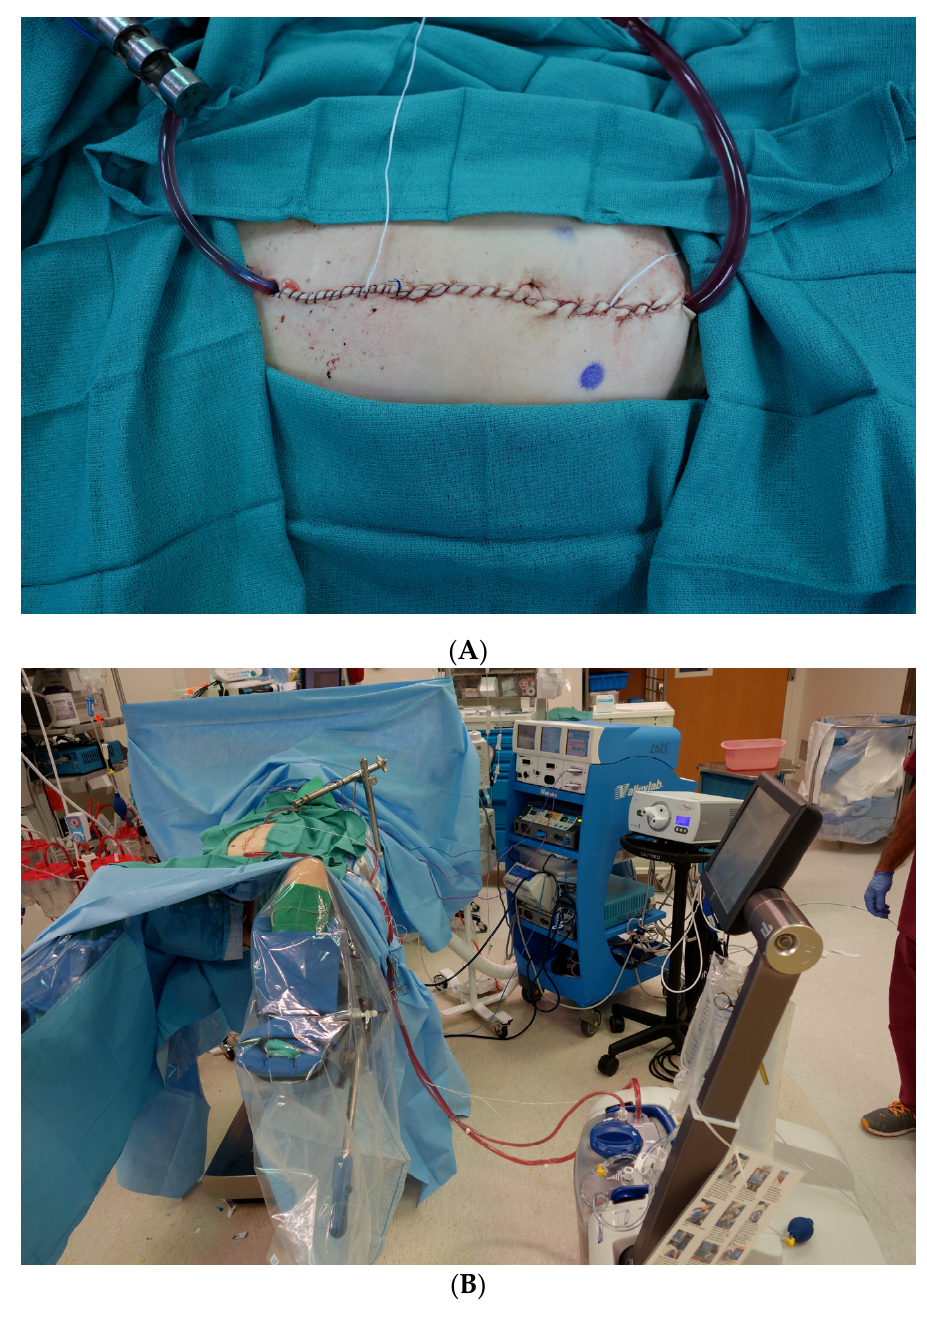
Figure 1. Hyperthermic Intraperitoneal Chemotherapy Perfusion During Cytoreductive Surgery. ( A ): Closed HIPEC Technique. The midline incision is temporarily closed to create a closed system for the infusion of chemotherapy into the peritoneal cavity. ( B ): HIPEC Room Set-Up. Operating room set-up during HIPEC, with inflow and outflow peritoneal catheters connected to the perfusion